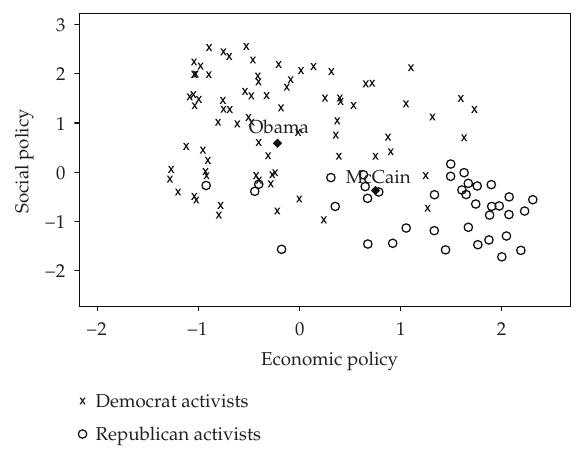
Figure 4: Distribution of activist ideal points and candidate